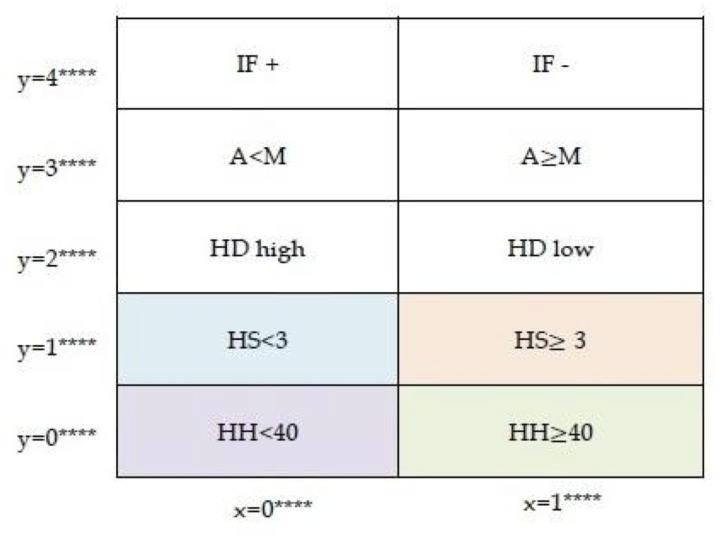
Regions in S
5 determined by the first significant variable.Observed units that often stay in a region determined by one significant variable often experience the property of that region.